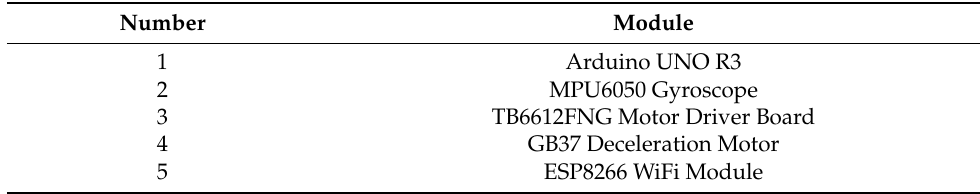
Figure 2. Unmanned ground vehicle (UGV). Table 1. UGV